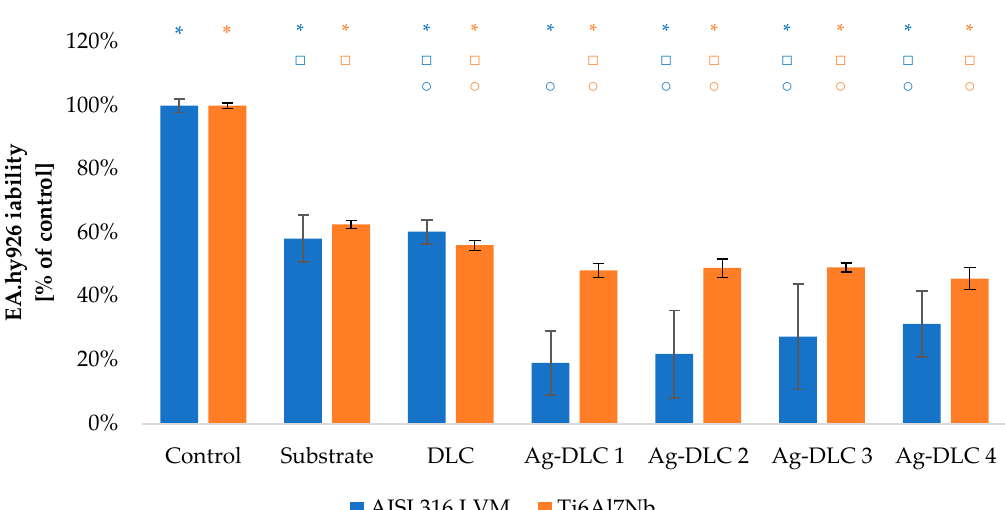
Figure 13. Evaluation of viability of EA.hy926 cell on the surface of Ag-DLC coatings deposited on AISI 316LVM and Ti6Al7Nb (live/dead test). Total number of cells expressed as a percentage of control.